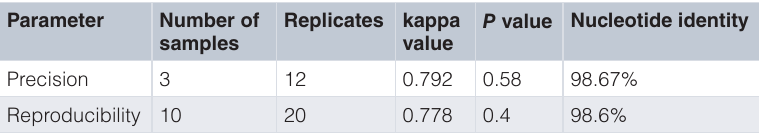
Table 4. Precision and reproducibility of genotyping using the original and modified assay.